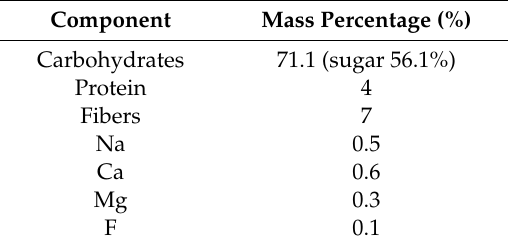
Table 1. Composition of cane molasses (dry base). Spanish